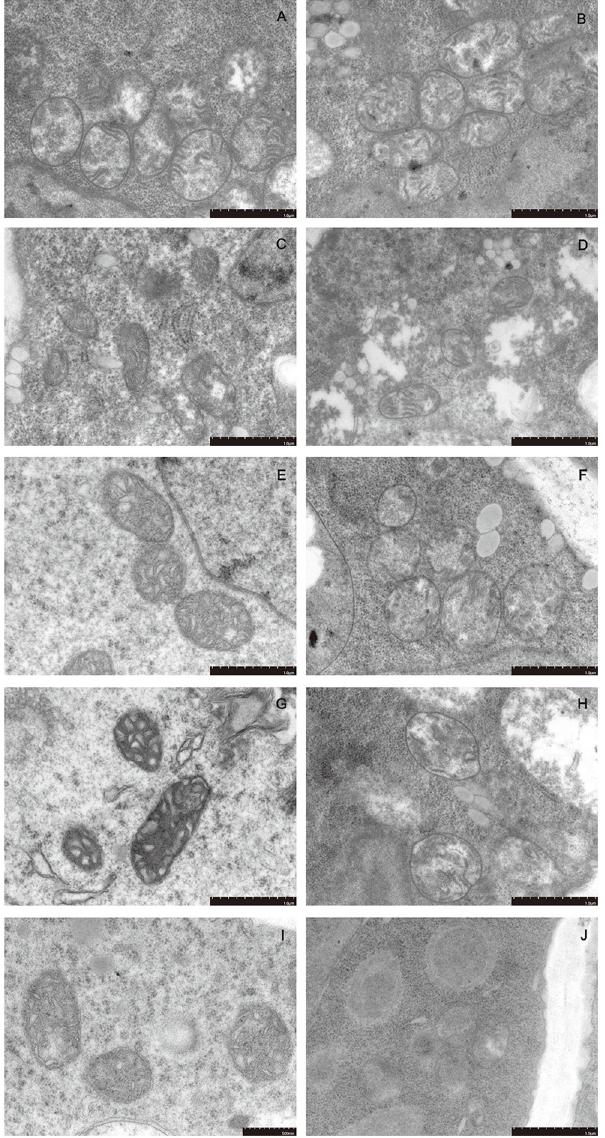
Fig 6. Ultrastructure of meristematic cell mitochondria in different preimbibition and dehydration states. A, C, E, G and I show meristematic cell mitochondria of the hypocotyl at 0, 3, 6, 18 and 24 h of preimbibition, respectively. B, D, F, H and J show meristematic cell mitochondria of the hypocotyl with 0, 3, 6, 18 and 24 h of preimbibition after 24 h of dehydration, respectively.